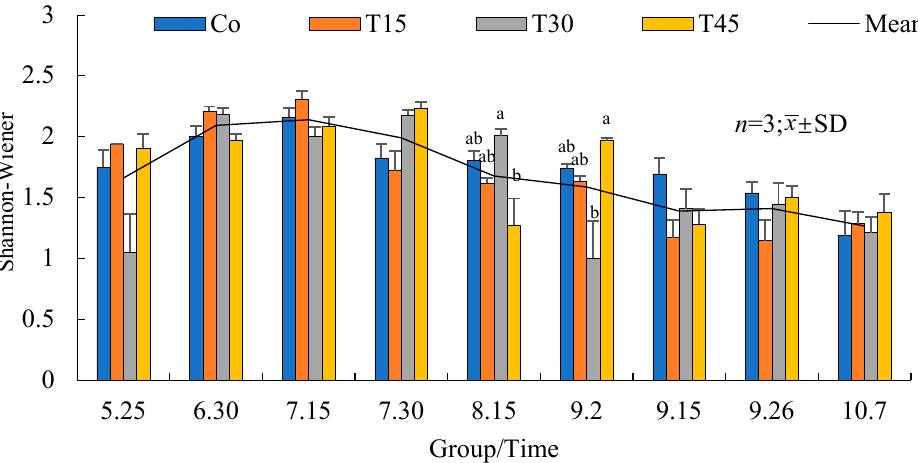
(1.73 average), respectively. group